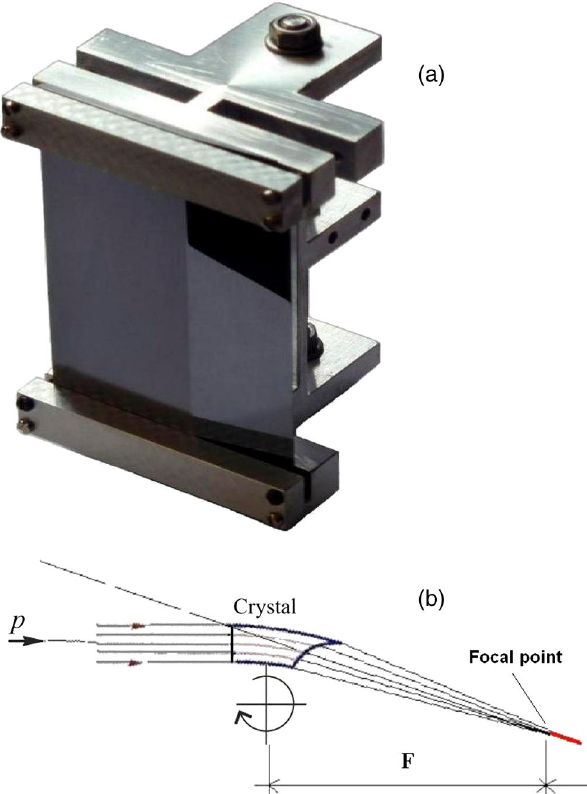
FIG. 2. (a) Photograph of a crystal holder with a focusing Crystal 1; (b) beam focusing scheme using a bent single crystal. For the linear cut, particles accepted in the channeling regime have different bending angles (at different transverse coordinates) and they are focused at some distance from the single crystal.